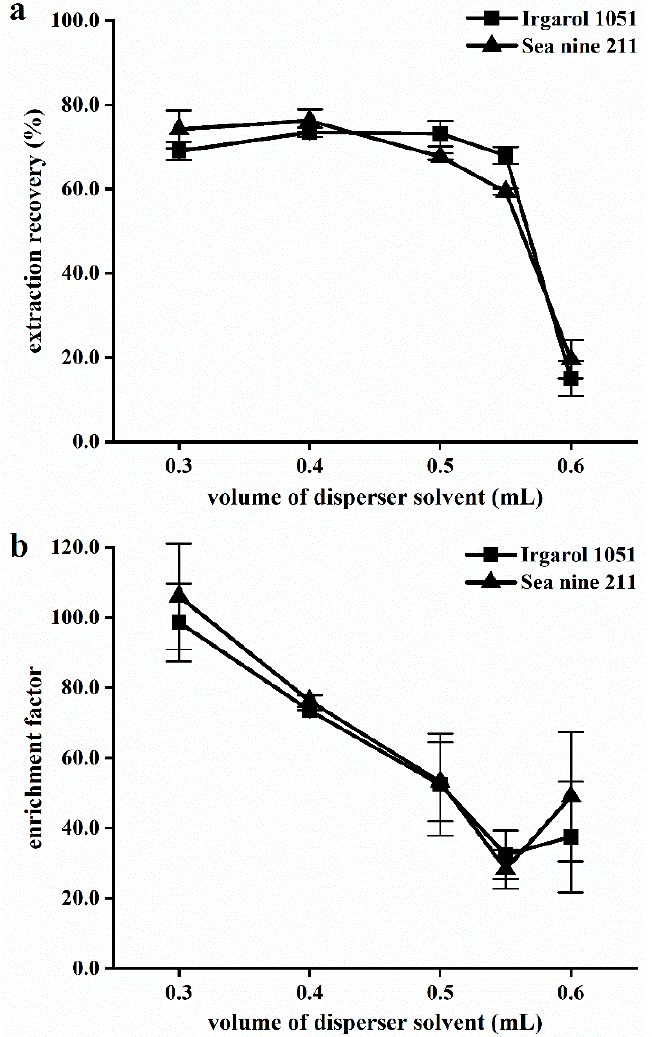
Figure 2. Effect of ethyl acetate volume on ( a ) extraction recovery and ( b ) enrichment factor. Extrac- tion conditions: water sample, 5.0 mL; extraction solvent [HMIm][PF6] 60 mg; NaCl 0% ( w / v ).; pH 6; and cooling temperature 20 °C.